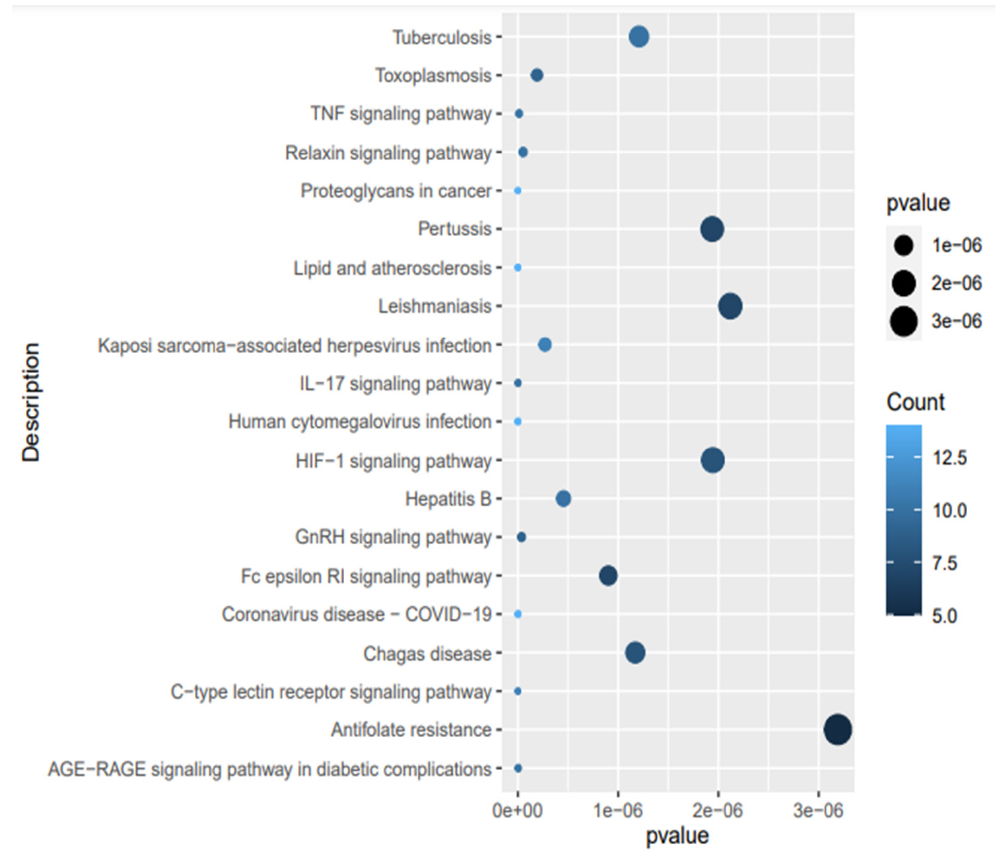
Figure 8: KEGG pathway analysis. Figure 8. KEGG pathway analysis. Table 3. Docking results show the binding energies of potential targets with compounds. The green color shows the high, yellow color show that moderate while red color show low binding energy. Binding Energy (kcal/mol) Compounds AKT1 MAPK1 MAPK14 CASP3